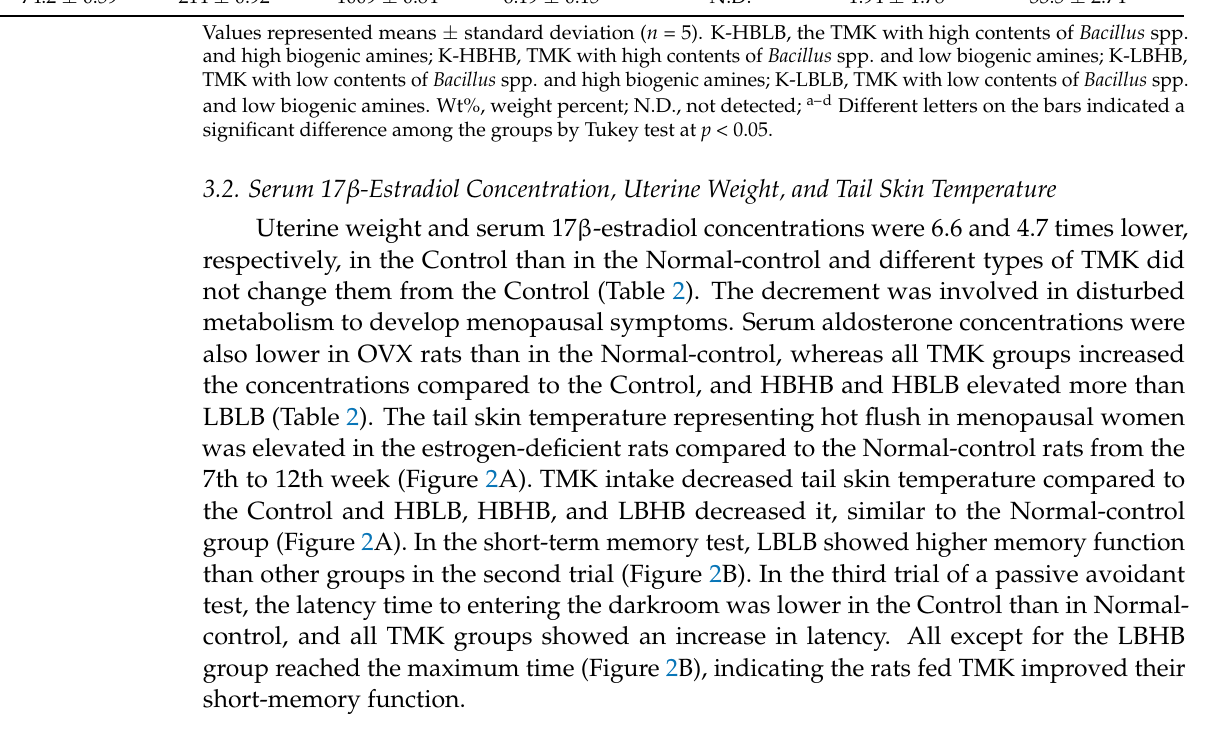
Table 2. Uterine weight and energy